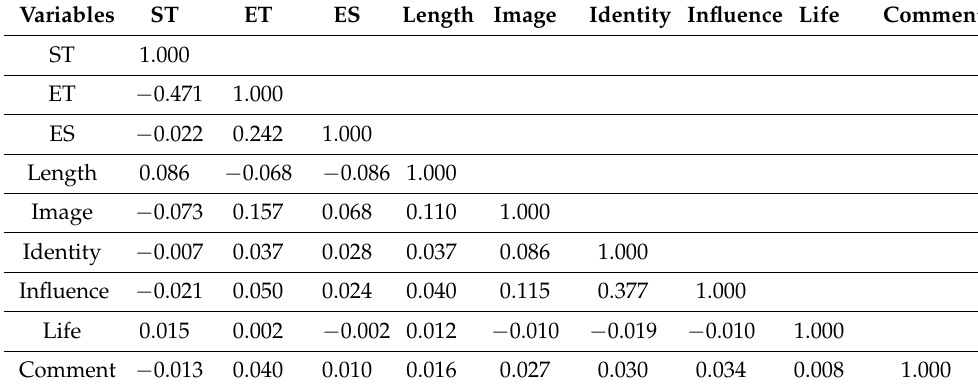
Table 3. Correlation coefficient table.